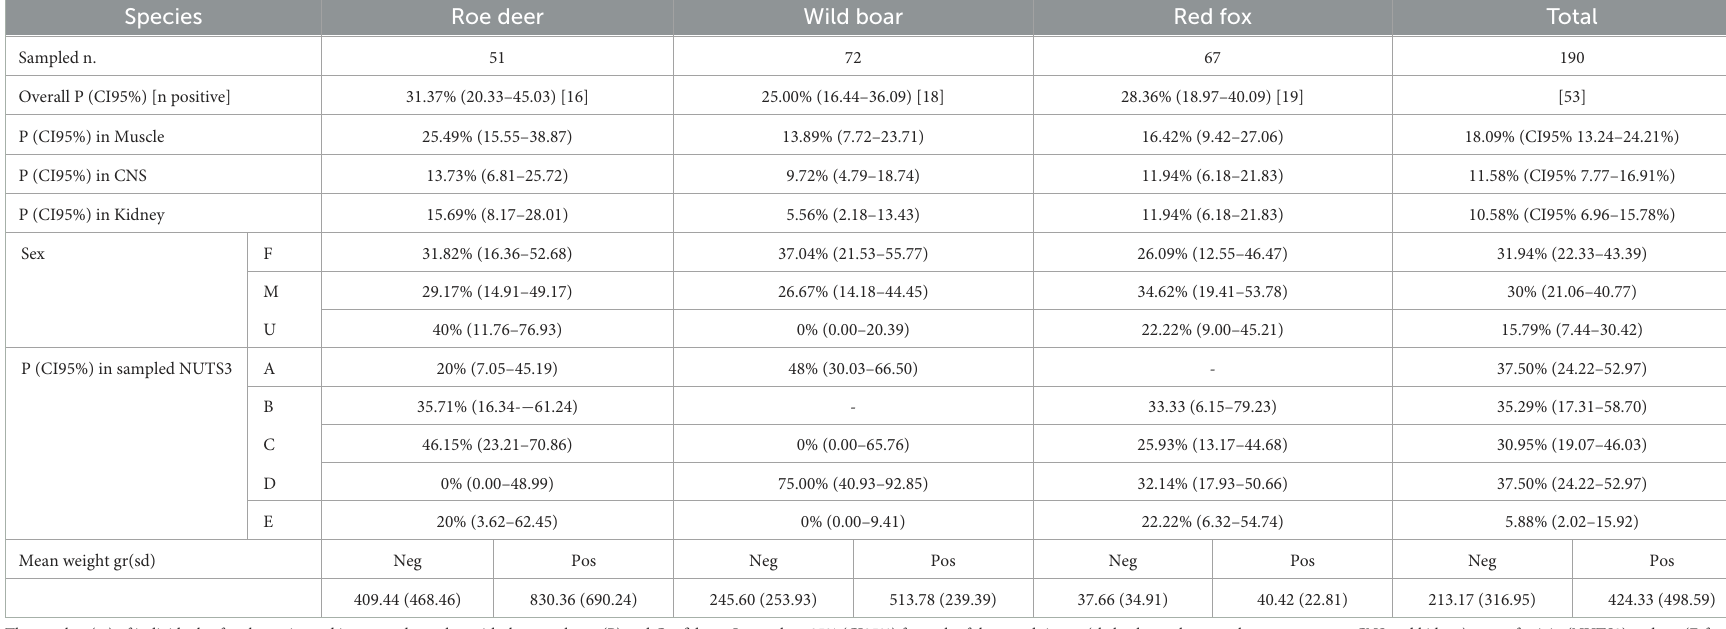
TABLE 3 Prevalence of Neospora caninum infection in fetuses of roe deer, wild boar, and red fox. Species Roe deer Wild boar Red fox Total Sampled